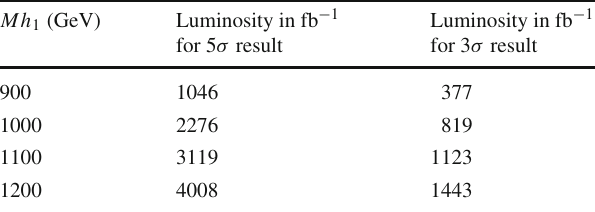
Table 3 Integrated luminosity in fb − 1 for 5 σ and 3 σ sensitivities Mh 1